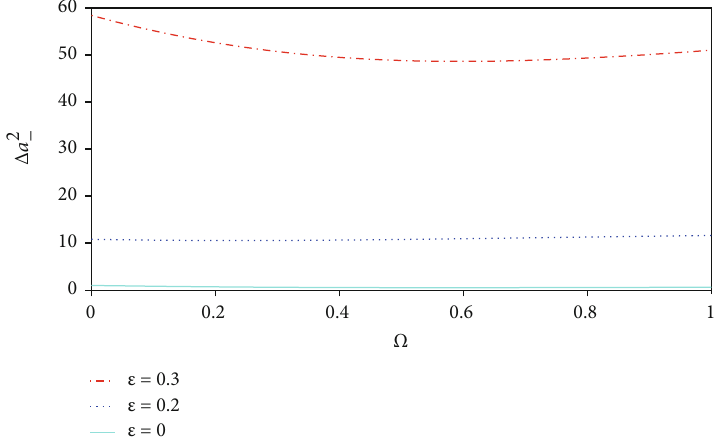
Ω for γ = 0 : 4 , k = 0 : 8 , N = 50, and for di ff erent values of γ c